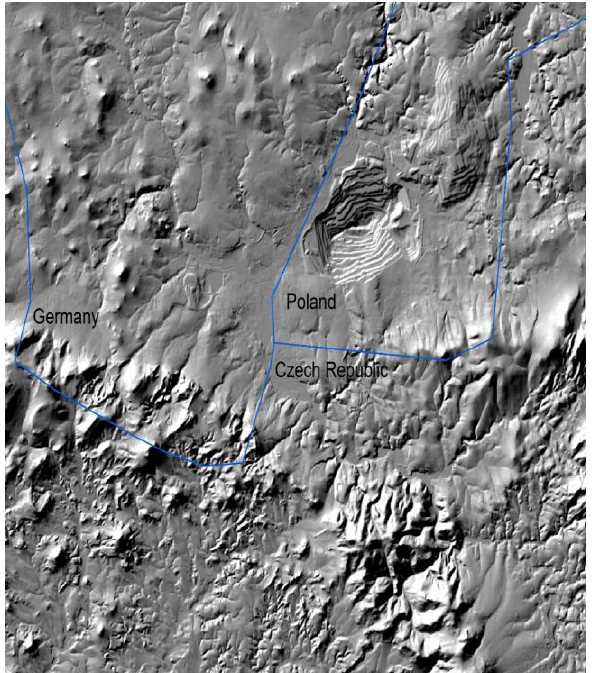
Figure 3. EuroDEM30 Pilot (DE-PL-CZ case study based on data provided by BKG, GUGiK and